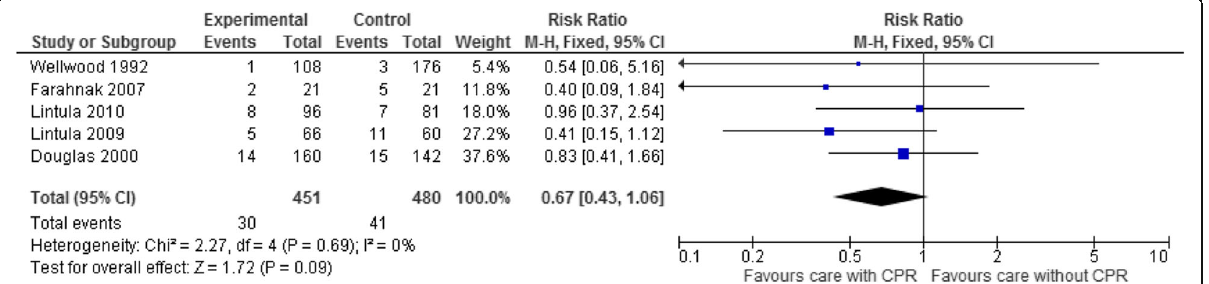
Fig. 4 Meta-analysis of appendicitis studies for the outcome unnecessary